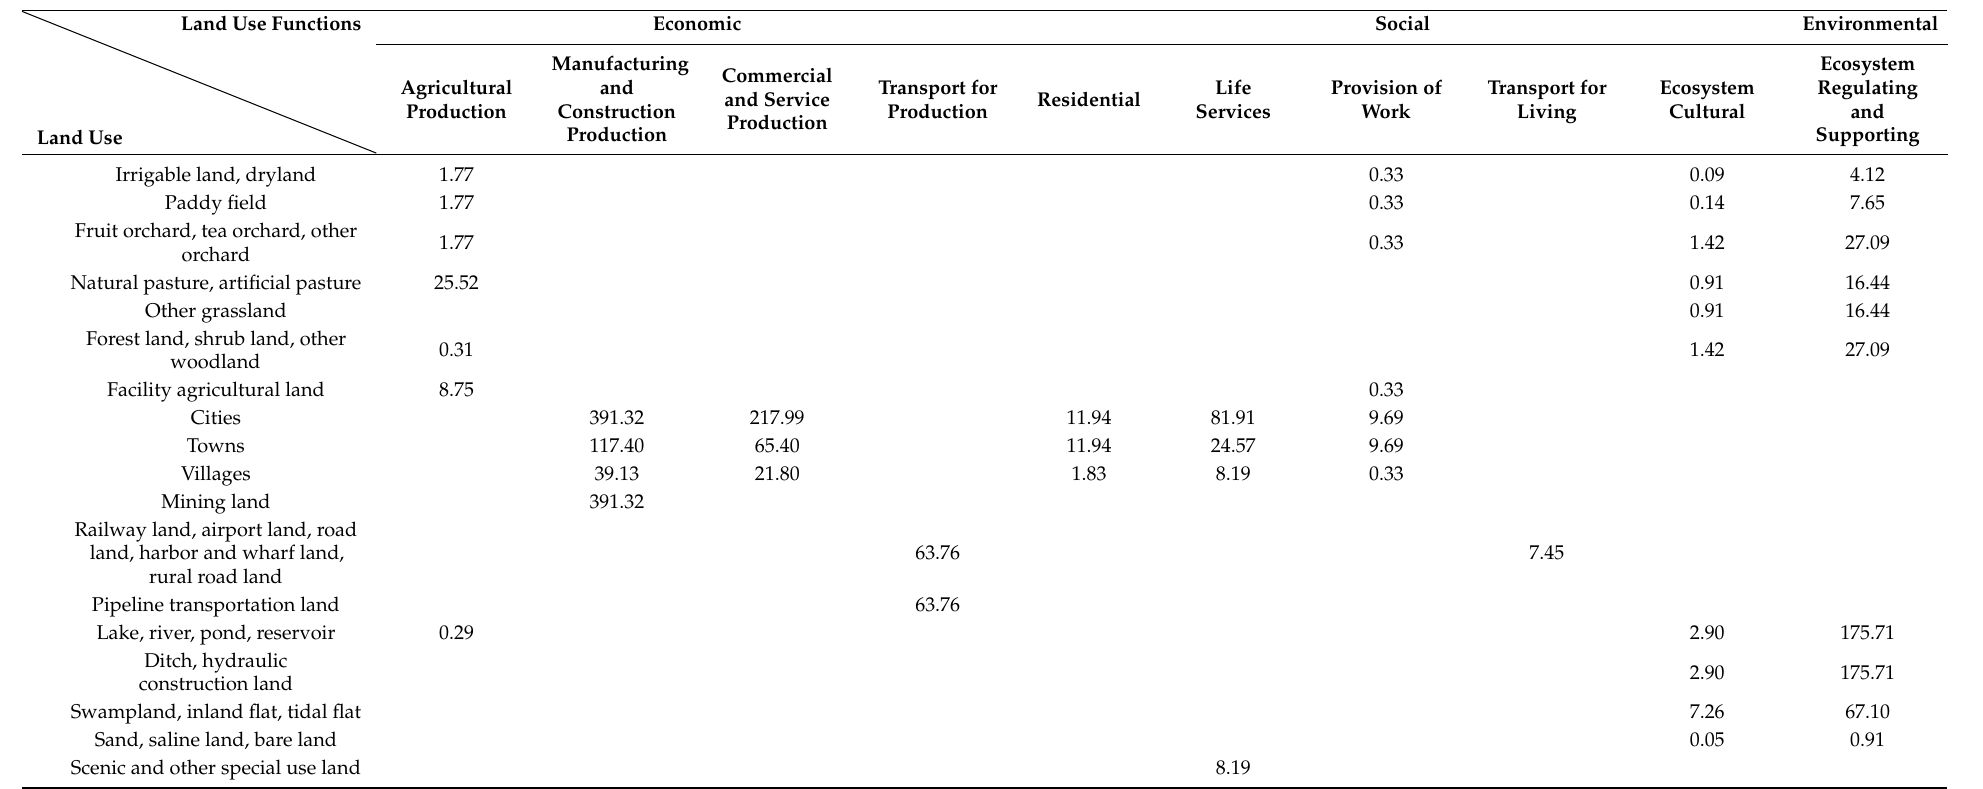
Table A2. Land use–land use function value matrix. (Taking Dongying City in 2009 as an example; unit: yuan/m 2